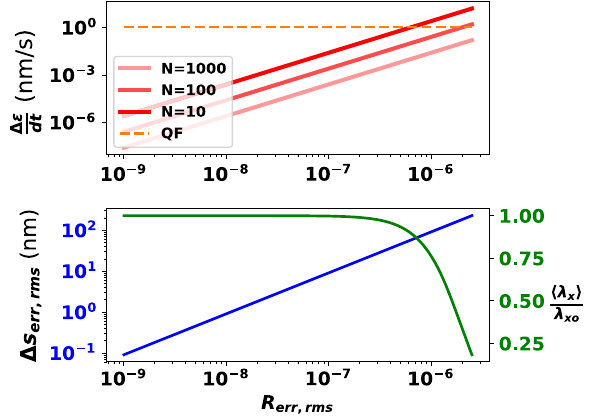
FIG. 6. Top: computed emittance growth rates from dipole fluctuations as a function of ring wide rms relative dipole error and the rate from QF of synchrotron radiation. Bottom: the expected rms path-length jitter (blue) and OSC damping rate reduction (green) as a function of rms relative dipole